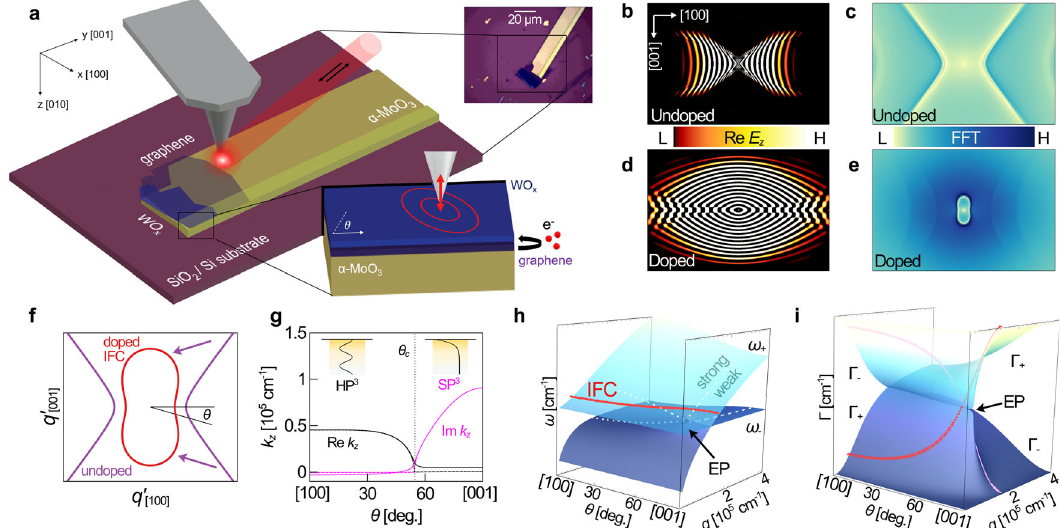
Fig. 1 Doping-induced topological transition by plasmon-phonon hybridization. a Graphene/ α -MoO 3 device schematic in a scattering-type scanning near- fi eld optical microscope (s-SNOM). Inset shows an optical microscope image of a sample. Graphene doping is achieved via charge transfer with WO x . The s-SNOM tip acts as a dipole antenna, launching polaritons in all permitted directions with in-plane angle θ . Without doping, there is no propagation along [001] direction and the, b wavefront and, c isofrequency contour (IFC) are hyperbolic. Upon doping, propagation is allowed along the [001] direction and the, d wavefront and, e isofrequency contour of the fi rst-order mode are closed curves. f Semi-analytical IFC undergoing topological transition upon doping. g Along the [100] direction, polaritons have out-of-plane propagation constant k z with Re k z » Im k z such that the out-of-plane electric fi eld is oscillatory like a waveguide mode (HP 3 , left inset). Along the [001], Im k z » Re k z and polaritons are surface waves with decaying electric fi eld (SP 3 , right inset). h Plasmon mode splitting ( ω pl ! ω þ & ω (cid:3) ) caused by the [100] α -MoO 3 phonon as a function of q and θ . The plot reveals an exceptional point (EP). The doped IFC from f is a curve on the ω þ surface (red line). The IFC passes about the EP, indicating a transition from strong to weak coupling. White dotted lines are guides to the eye. i Scattering rates Γ + & Γ − of ω + & ω − modes are anticorrelated (compare red and pink